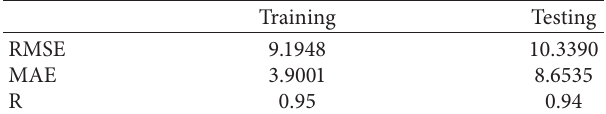
Table 3: Pearson’s correlation coefficient (R), Mean Absolute Error (MAE), and Root Mean Square Error (RMSE).